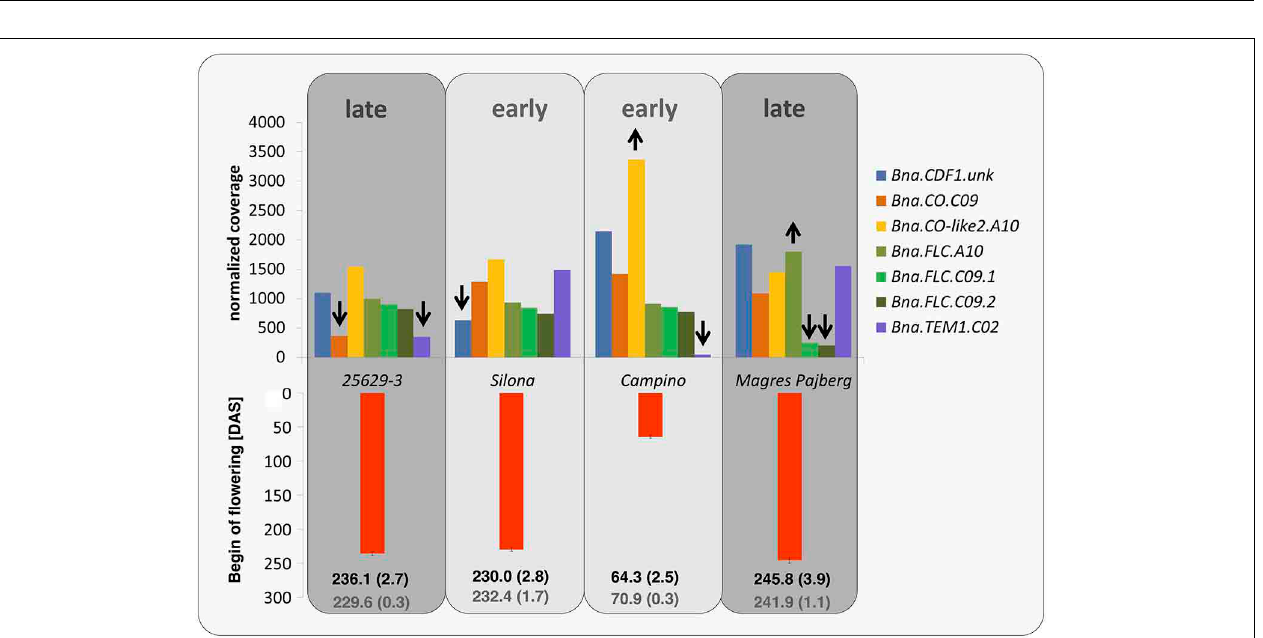
FIGURE 5 | Normalized coverage for gene copies with copy-number variation or presence-absence variation. A reduction in copy number compared to the Darmor-Bzh reference genome is indicated by the downwards arrows, an increased copy number by the upwards arrows. The red bars indicate flowering time in days after sowing (DAS), averaged over 3